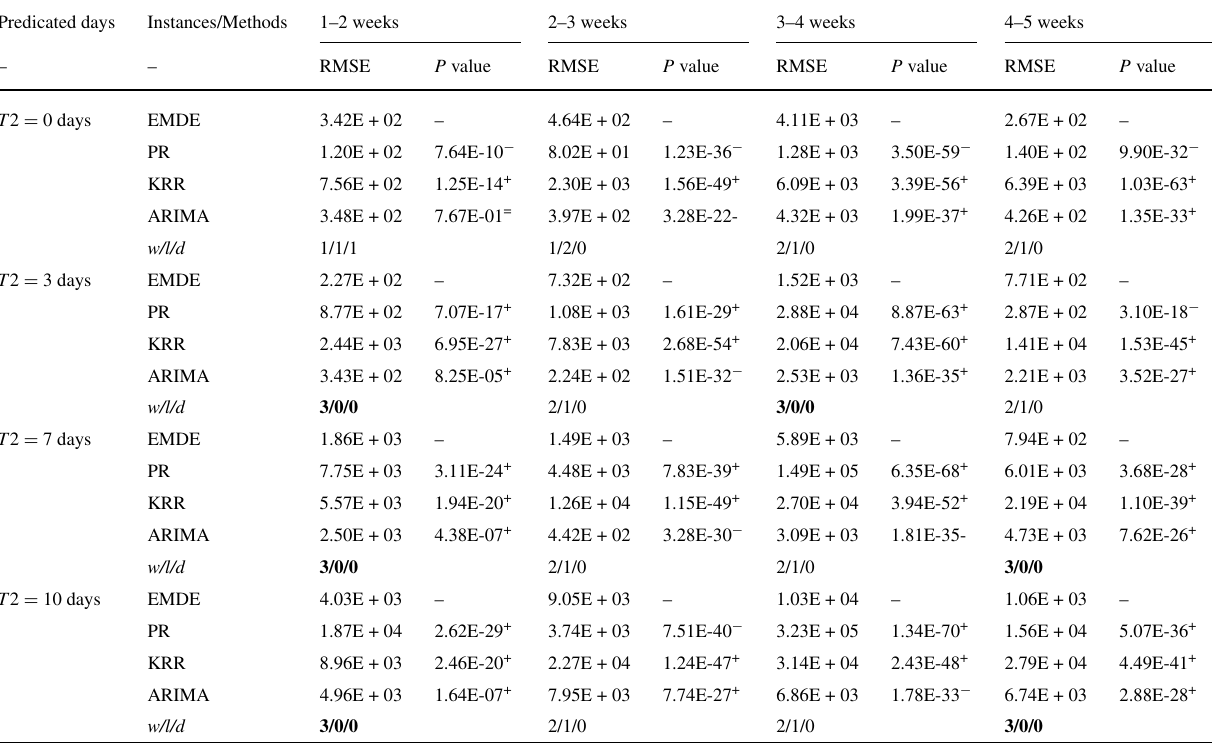
Table 3 Comparison results with data-driven methods for simulation days being 7 days ( T 1 (cid:2) 7) Predicated